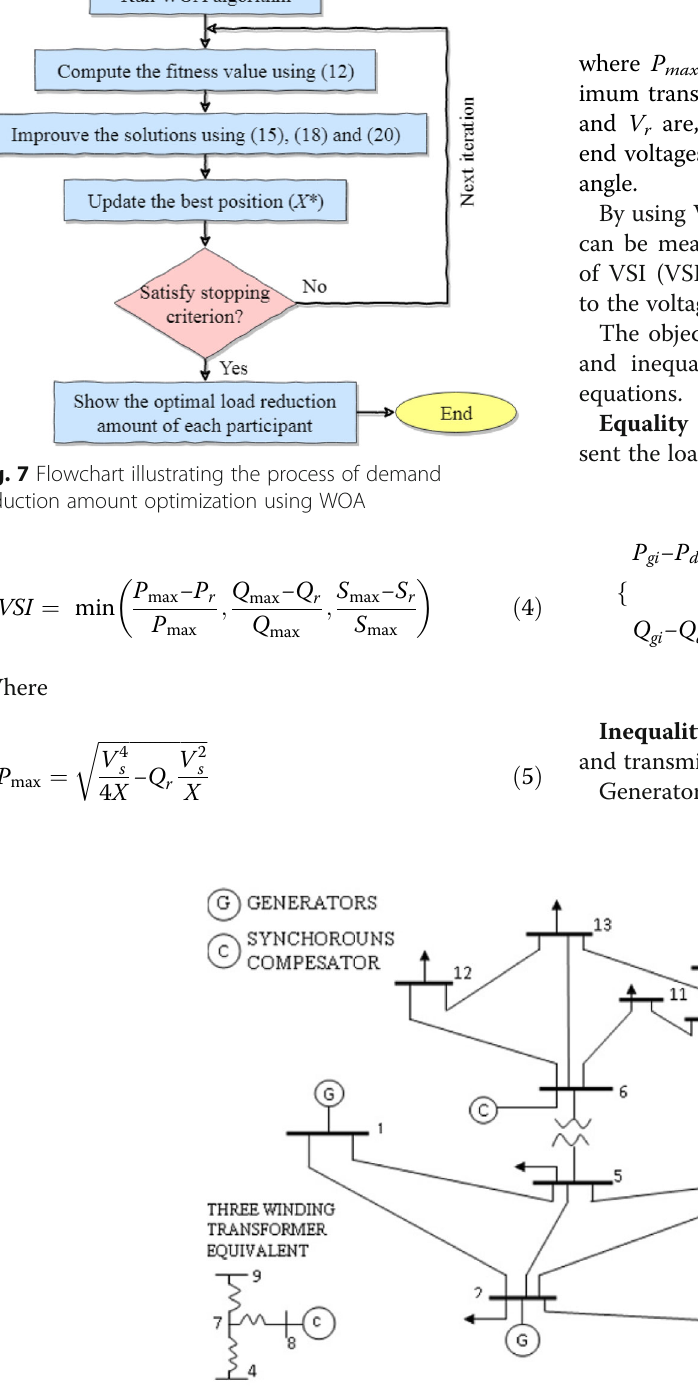
Fig. 8 Single line diagram of the IEEE 14-bus test